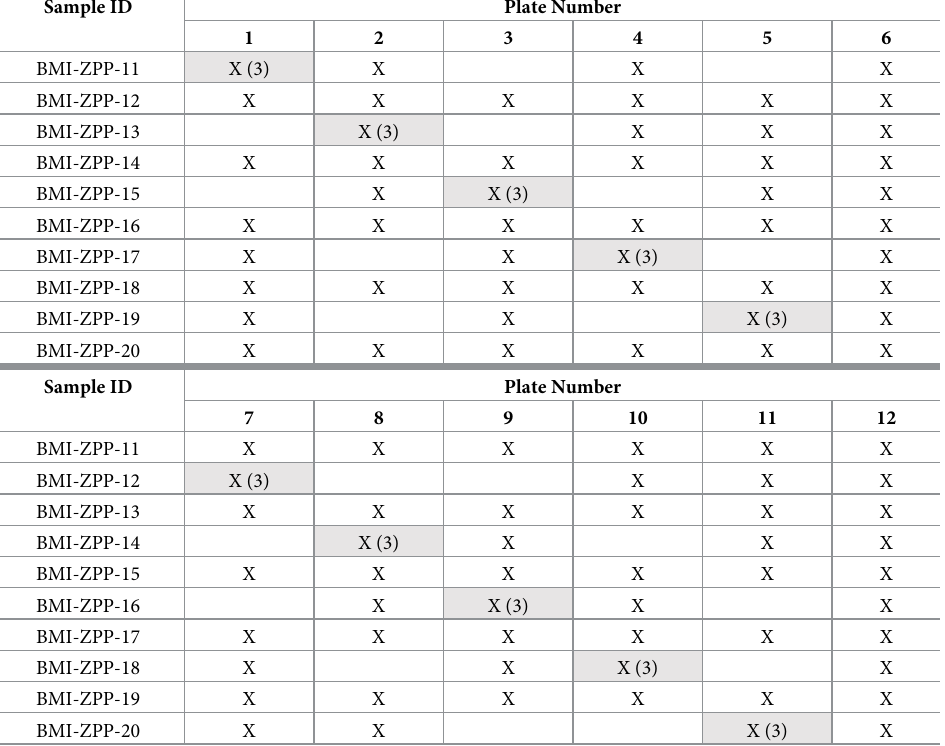
Table 2. Plate layout used at Laboratories C and D. Sample ID